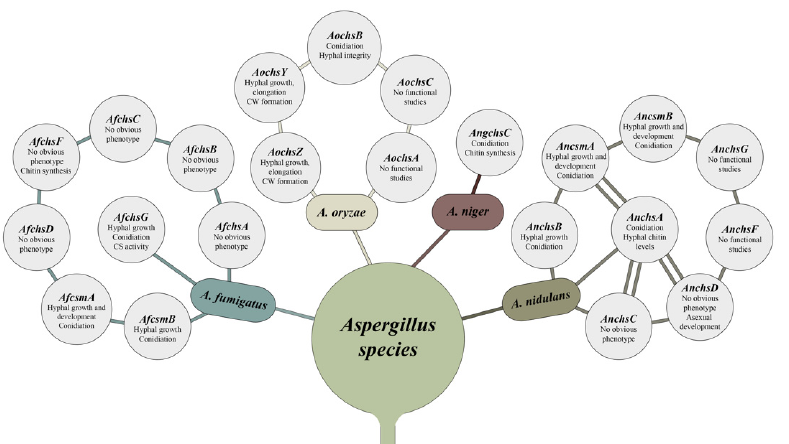
Figure 3. An overview of the functions of chitin synthases (CS) in different Aspergillus species. The functional description is based on studies using the respective gene deletion strain. The diagram also depicts CS whose gene deletion has not been carried out and, thus, where no functional studies were performed. Our understanding of the role of CS in Aspergillus species is mainly derived from A. nidulans and A. fumigatus . Overlapping functions between AnchsA and AnchsC in hyphal growth and conidiation, between AnchsA and AnchsD in conidiation and between AnchsA and AncsmA in hyphal integrity under low osmotic conditions in A. nidulans are depicted with a double line.